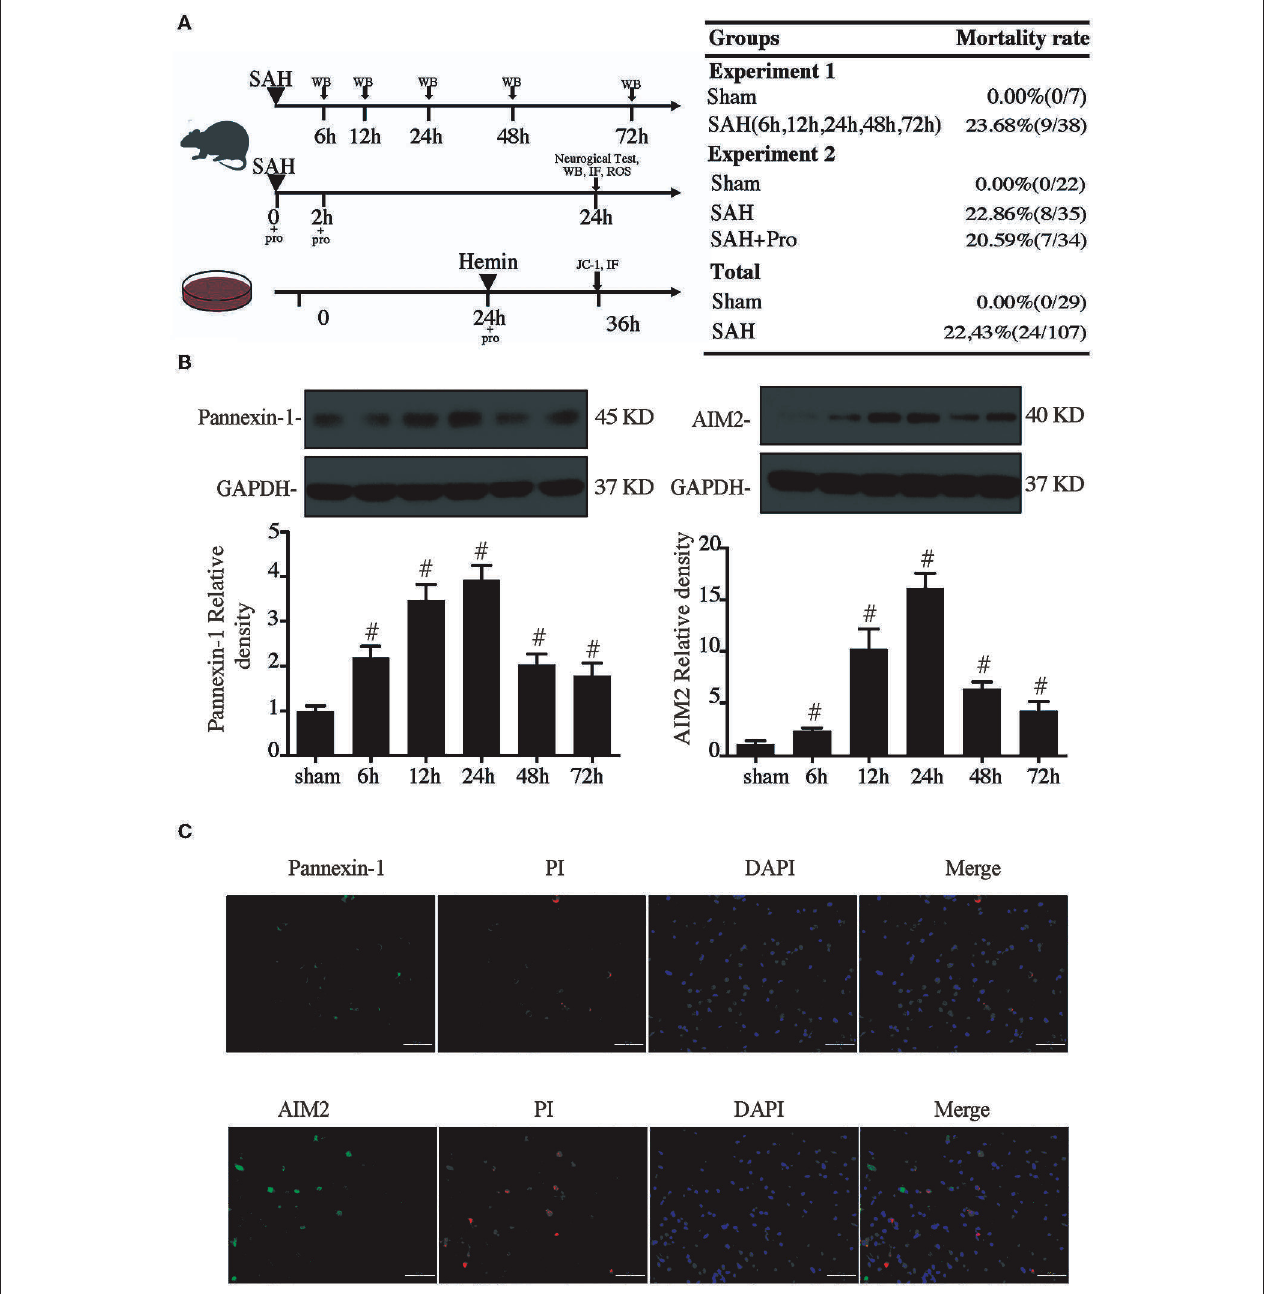
FIGURE 1 | (A) Experimental design for in vivo and in vitro experiments, animal groups, and mortality. (B) Time course of pannexin-1 and AIM2 levels, n = 4 for each group. # p < 0.05 vs. sham group. (C) Representative micrographs showing double immunofluorescence labeling of propidium iodide (PI) with pannexin-1 and AIM2 in the ipsilateral basal cortex at 24h after subarachnoid hemorrhage (SAH). Scale bar = 50 µ m.